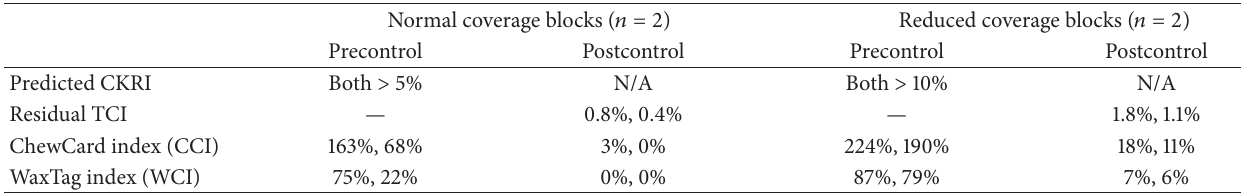
Table 1: Predicted (CKRI) and actual (residual TCI, CCI, and WTI) measures of the relative abundance of possums before and/or after aerial 1080 poisoning in four study blocks on Molesworth Station, 2008.